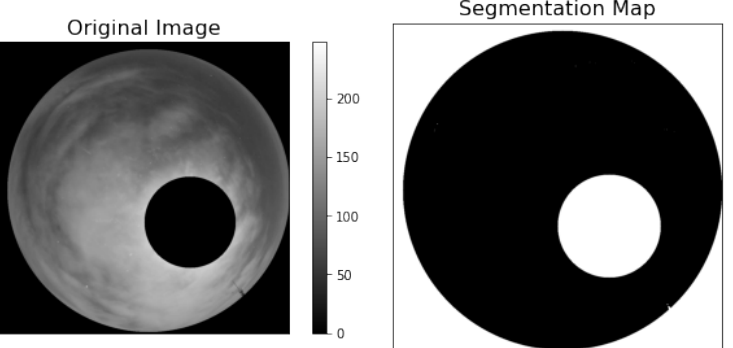
Figure 6. An example of the derived cloud segmentation map based on the Otsu method. The black color represents the regions clear of clouds and masked Moon, while the white color corresponds to regions covered by